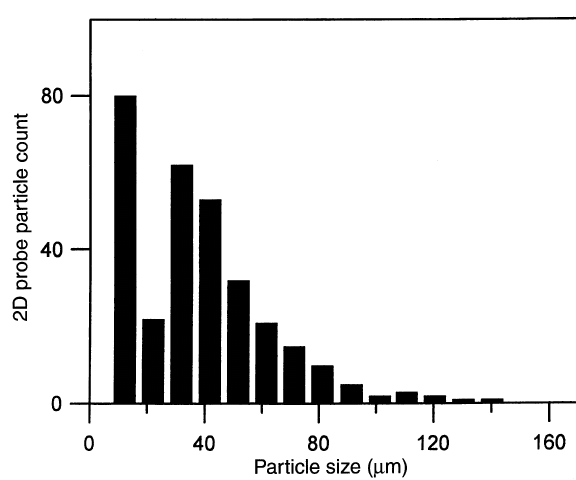
Fig. 15. Size distribution corresponding to Fig. 11